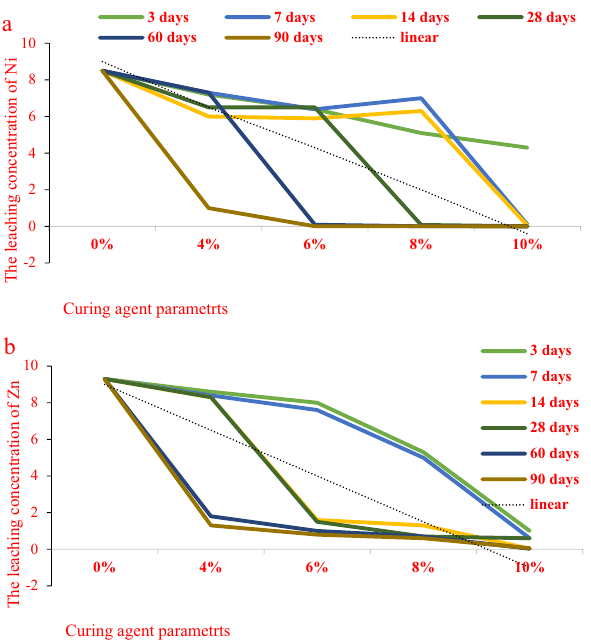
Figure 9. Leaching concentration of heavy metals in BCP-stabilized